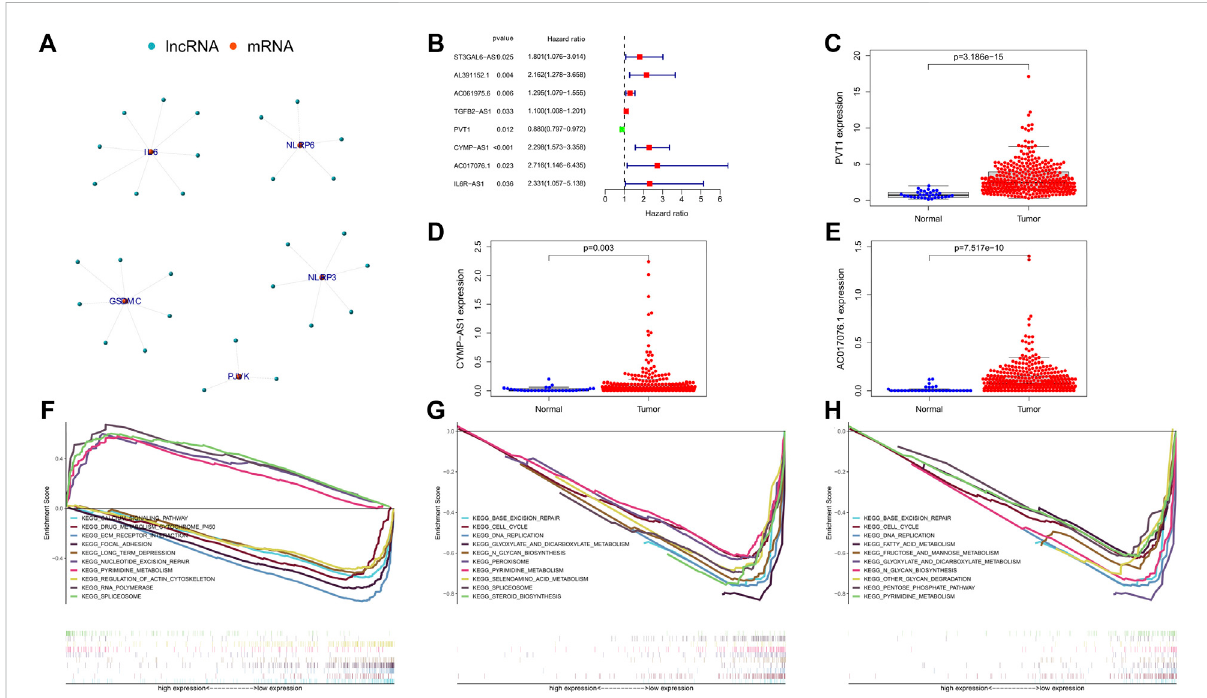
FIGURE 2 (A) Co-expression network of the pyroptosis-related mRNAs-lncRNAs was constructed and visualized using R. (B) The forest showed the HR (95% CI) and p -value of selected lncRNAs by univariate Cox regression analysis. (C – E) Visualization of the expression levels of lncRNAs with prognostic value expressed in human GC tumor tissues and adjacent normal tissues. (F – H) Represents the signi fi cantly enriched KEGG pathways of lncRNA PVT1, CYMP-AS1, and AC017076.1 in different expression level, respectively. GC, gastric